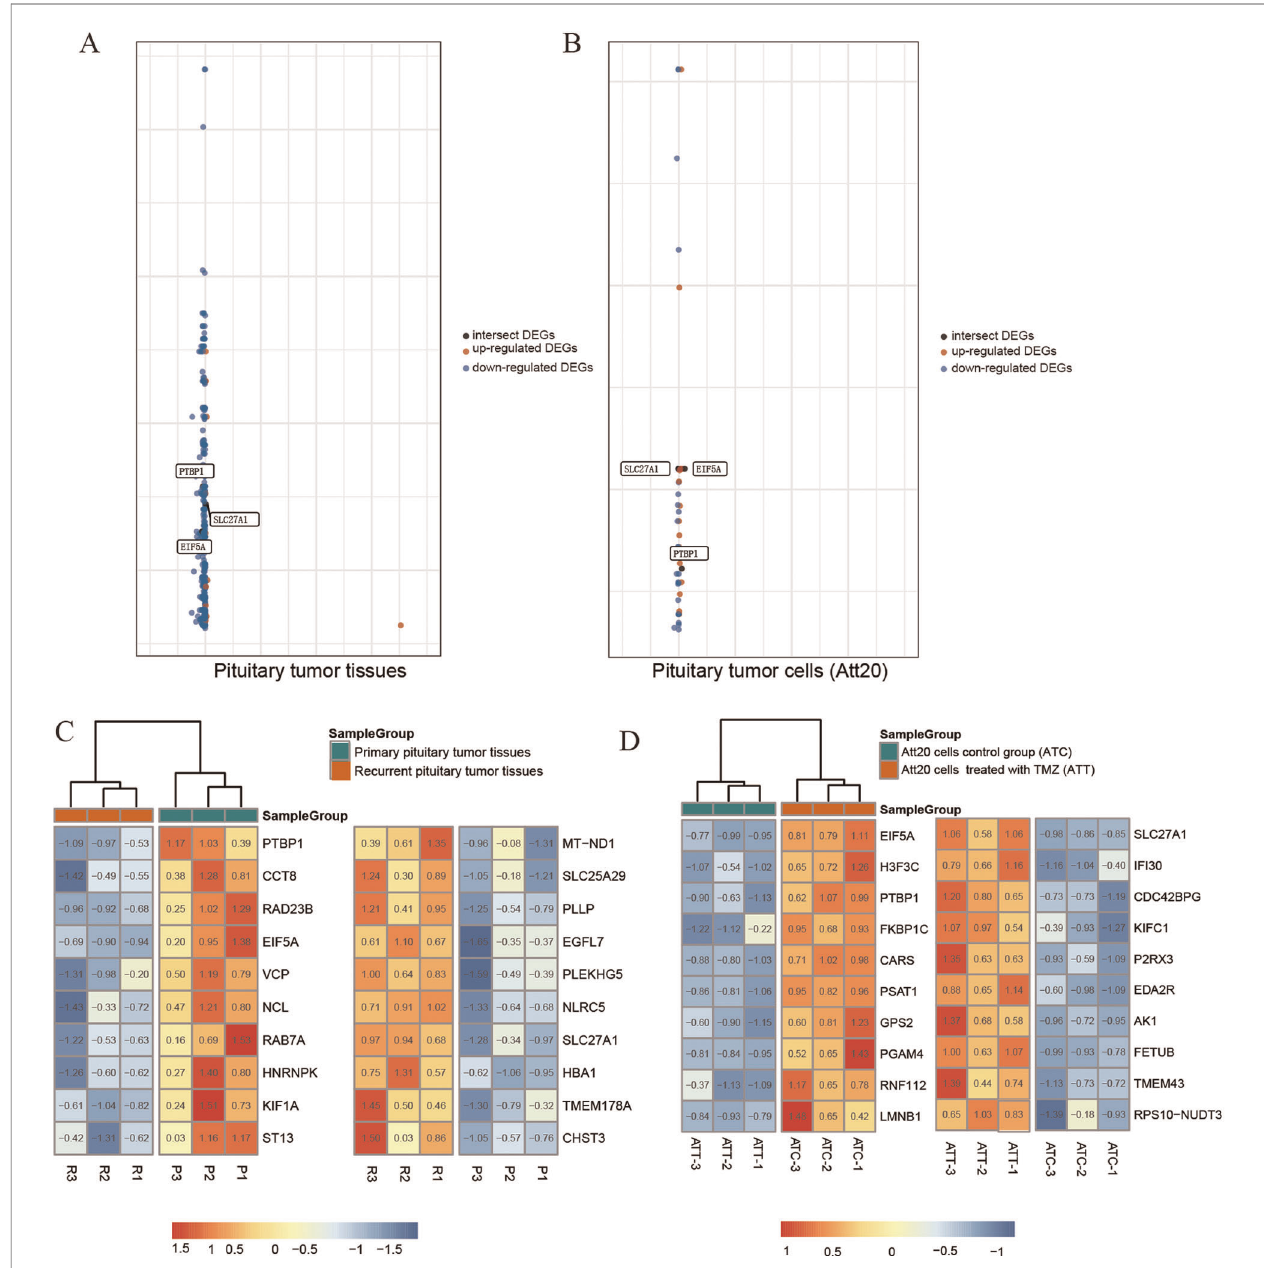
FIGURE 2 | The graph shows the distribution of datasets with statistically signi fi cant mRNA overexpression (Brown) or down-regulated expression (blue) of the target gene. Genes intersecting tumor tissue ( A ) with cell sequencing ( B ) are labeled in black. The threshold was designed with the following parameters: P -value <0.001, fold change >1.5 ( A , B ). Sequencing heat map results of pituitary tumor tissues and cells are presented ( C , D ). Among the differentially expressed genes, the top 10 genes in the high expression ranking were each selected for heat map plotting with the top 10 genes in the low expression ranking. SLC27A1, eIF5A, and PTBP1 were expressed in both tumor tissues and